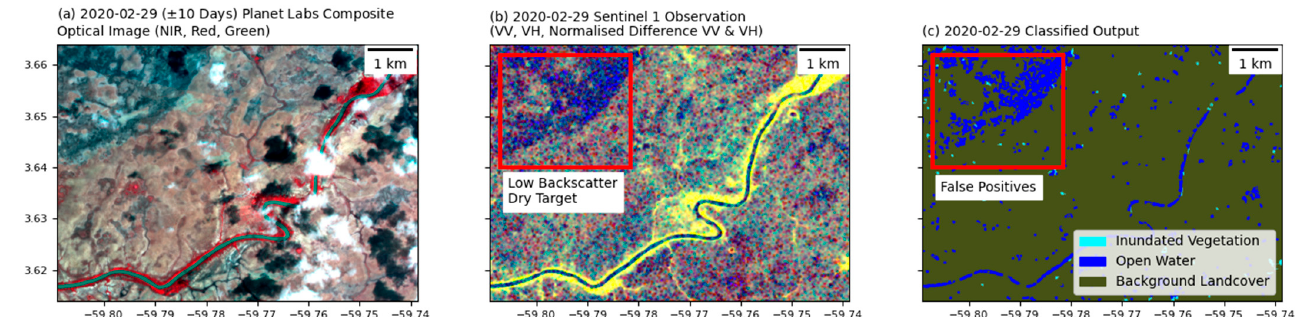
Figure 12. ( a ) PlanetLabs composite (False Colour: NIR, SWIR1, Red) [63], ( b ) Sentinel-1 Observation (False Colour: VV, VH, NDPI) and ( c ) RadWet output product dated 29 February 2020 showing a section of the Ireng river within the Rupununi Wetlands Region in Guyana where the Sentinel-1 Observation shows very low backscatter in the northeast, much lower than that of the Ireng river but is shown not to be open water in the PlanetLabs composite.